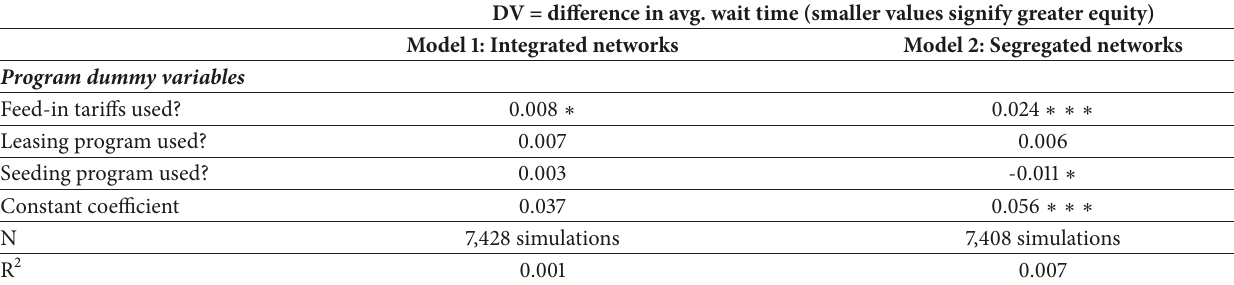
Table 4: Effect of incentive programs on distributional equity: integrated versus segregated social networks.